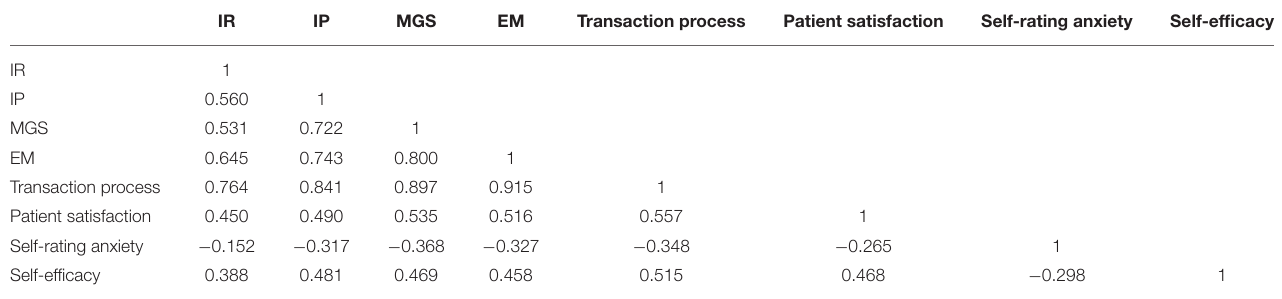
TABLE 2 | Spearman correlation analysis.